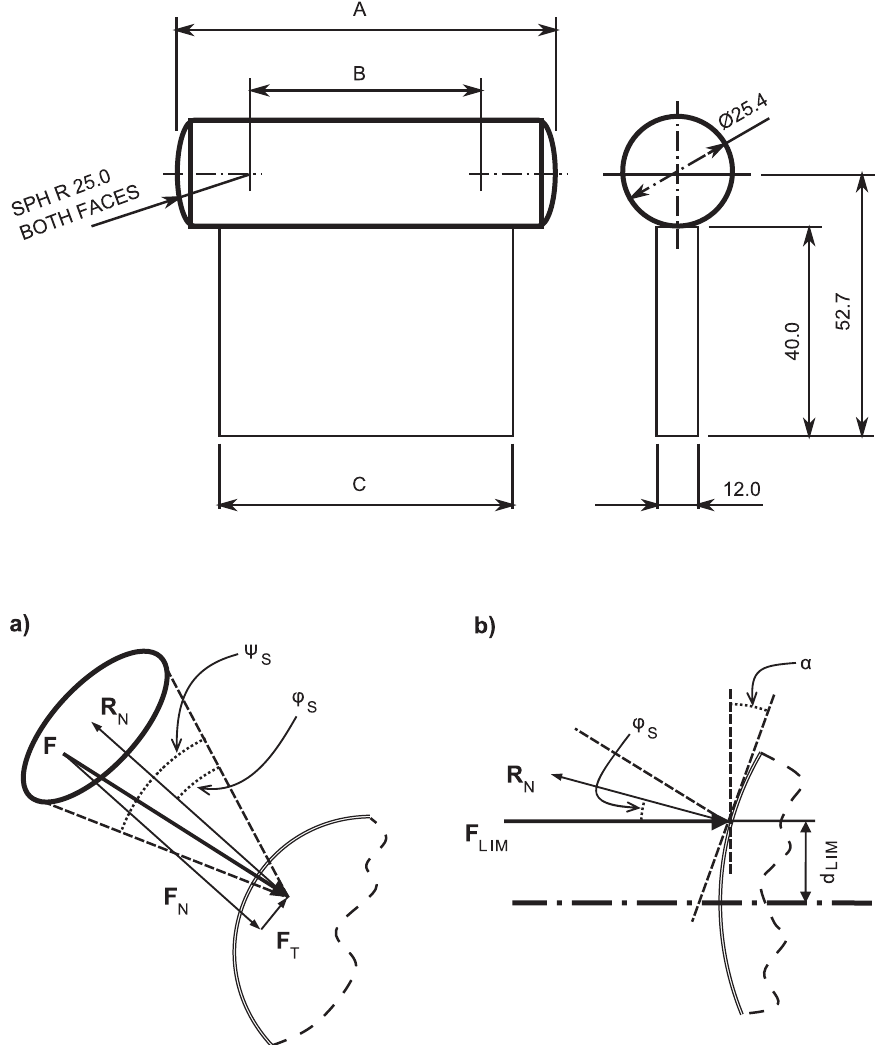
Figure 2. Object geometric properties friction-dependant functional grip area. Upper Geometric variation in stimulus sizes: Grip surface width ‘A’, the distance between the spherical surface centre-points ‘B’ and support base width ‘C’ were varied as discussed in the Method section. Lower a) Manually securing an object requires the frictional force to be greater than the tangential component of object weight at the interface between fingertip and object. A curved surface results in a normal reaction force direction (R N ) unique to the point at which the object is grasped. Fearing [14] demonstrated that, for a stable grasp, the grip conditions should satisfy: tan 2 1 |F t |/F n , tan 2 1 m or m F n . |F t |. For a stable lift, fingertip force should be applied within an angle of w s relative to the normal reaction force (R N ), where: w s =tan 2 1 m s . Extending this relationship in the direction of all tangential friction force directions generates a cone of friction of half-angle w s and cone angle y where: y =2 w s . b) As force is applied to the curved surface at a distance d LIM from the centreline of the radius, then the force is at an angle a to the surface normal. When a = w s the force lies at the limit of the cone of friction. An increase in d results in the force lying outside the cone of friction and unstable grasp. Thus w s , and d LIM are linked to the coefficient of static friction m s such that an increase in m s extends the functional area which can be grasped to achieve a stable grasp. (F(2,22) = 8.60, p , 0.01) (Figure 3), with a statistically reliable interaction between the two (F(2,22) =4.34, p , 0.05, e = 0.77). The narrow width object produced a similar proportion of on-the- fly movements in the medium and high friction conditions. It is not clear why this was the case, but the clear difference between these conditions and the low-friction target is the critical finding. We found no effect of distance (F(2,22) = 0.91, p =0.41), nor interactions of distance with width or surface texture. We explored the data to determine whether stop movements reliably followed a failed trial or whether ‘hysteresis’ could be observed in the data (where one trial influences the next) but we were unable to identify any discernible pattern.